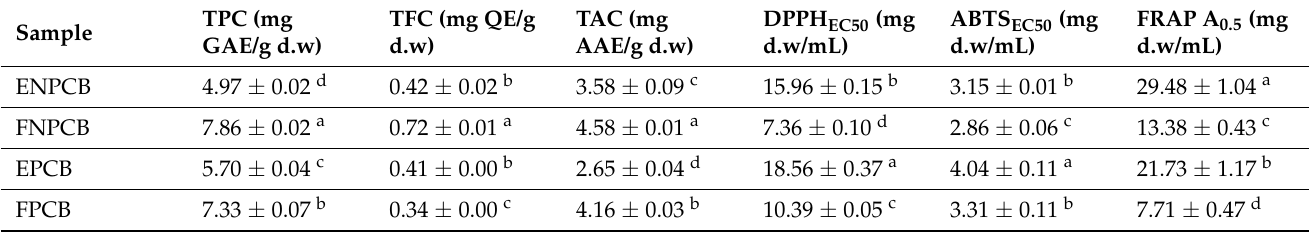
Table 8. Total phenolic content (TPC), total flavonoid content (TFC), and antioxidant activities of different gluten-free